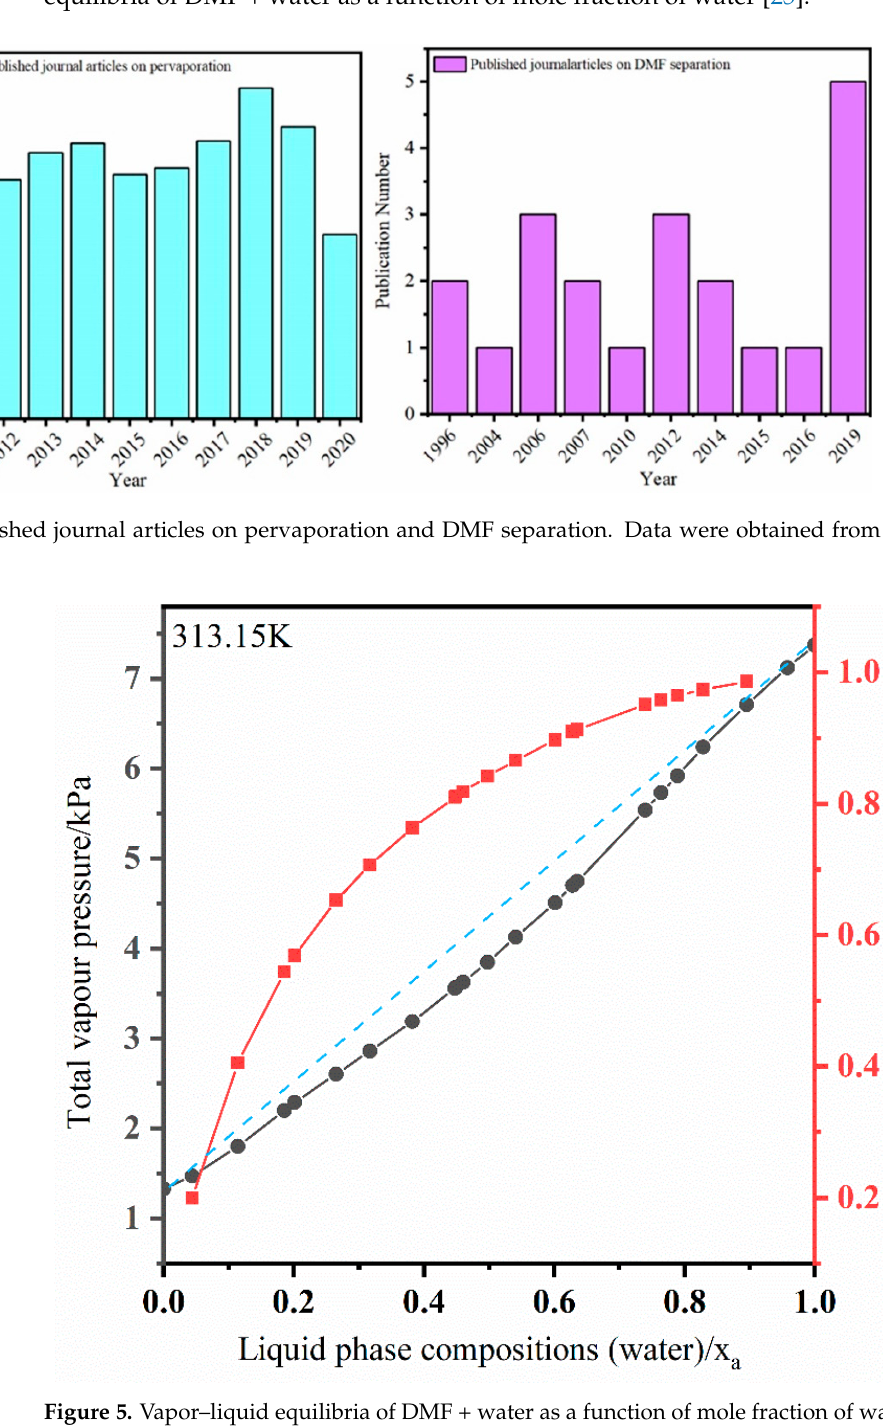
Figure 3. Graphical presentation of the solution–diffusion model.